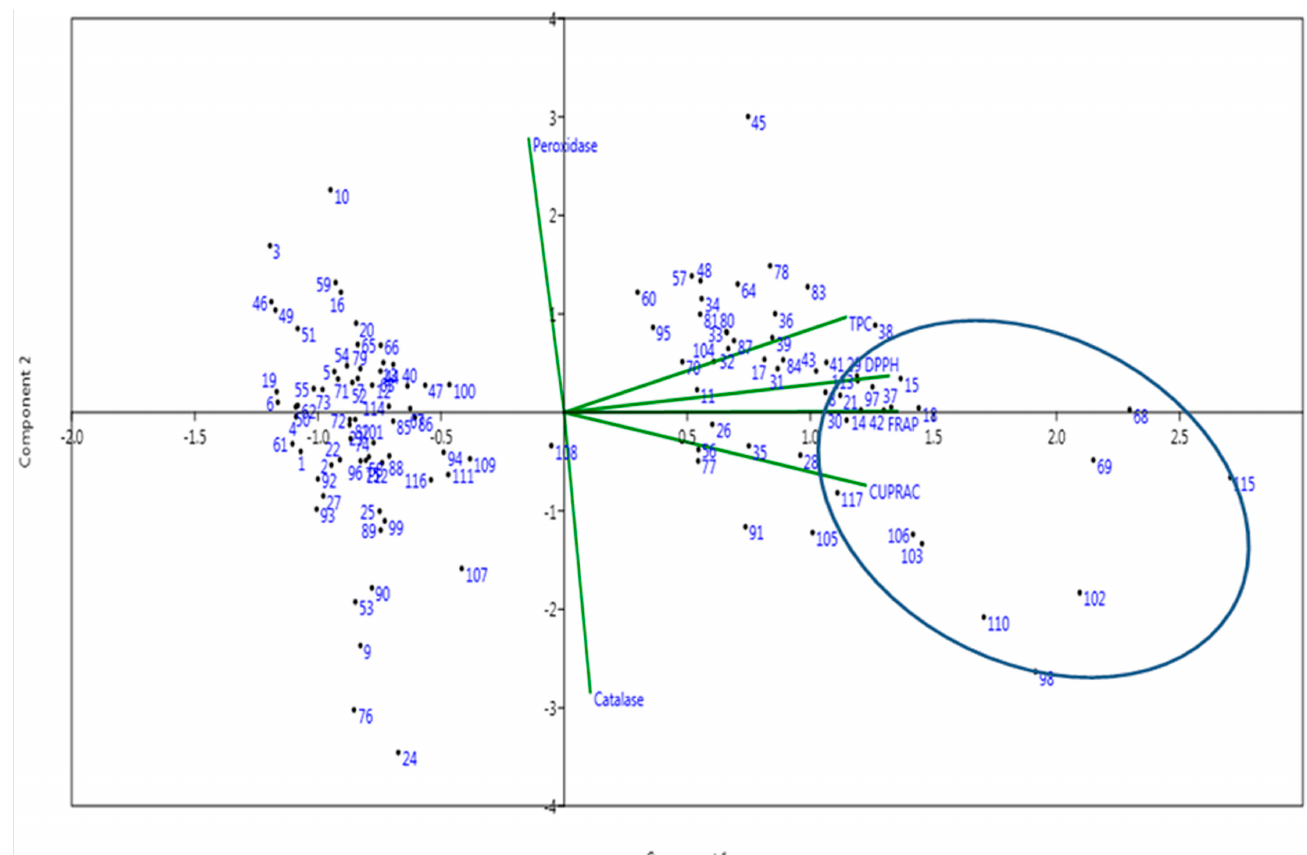
Figure 3. Genotype-by-trait biplot diagram of 117 germplasm lines in the two PCs for the antioxidant traits, catalase, peroxidase, total phenolics content (TPC), 2,2-diphenyl-1-picrylhydrazyl (DPPH), ferric reducing antioxidant power (FRAP) and cupric ion reducing antioxidant capacity (CUPRAC).